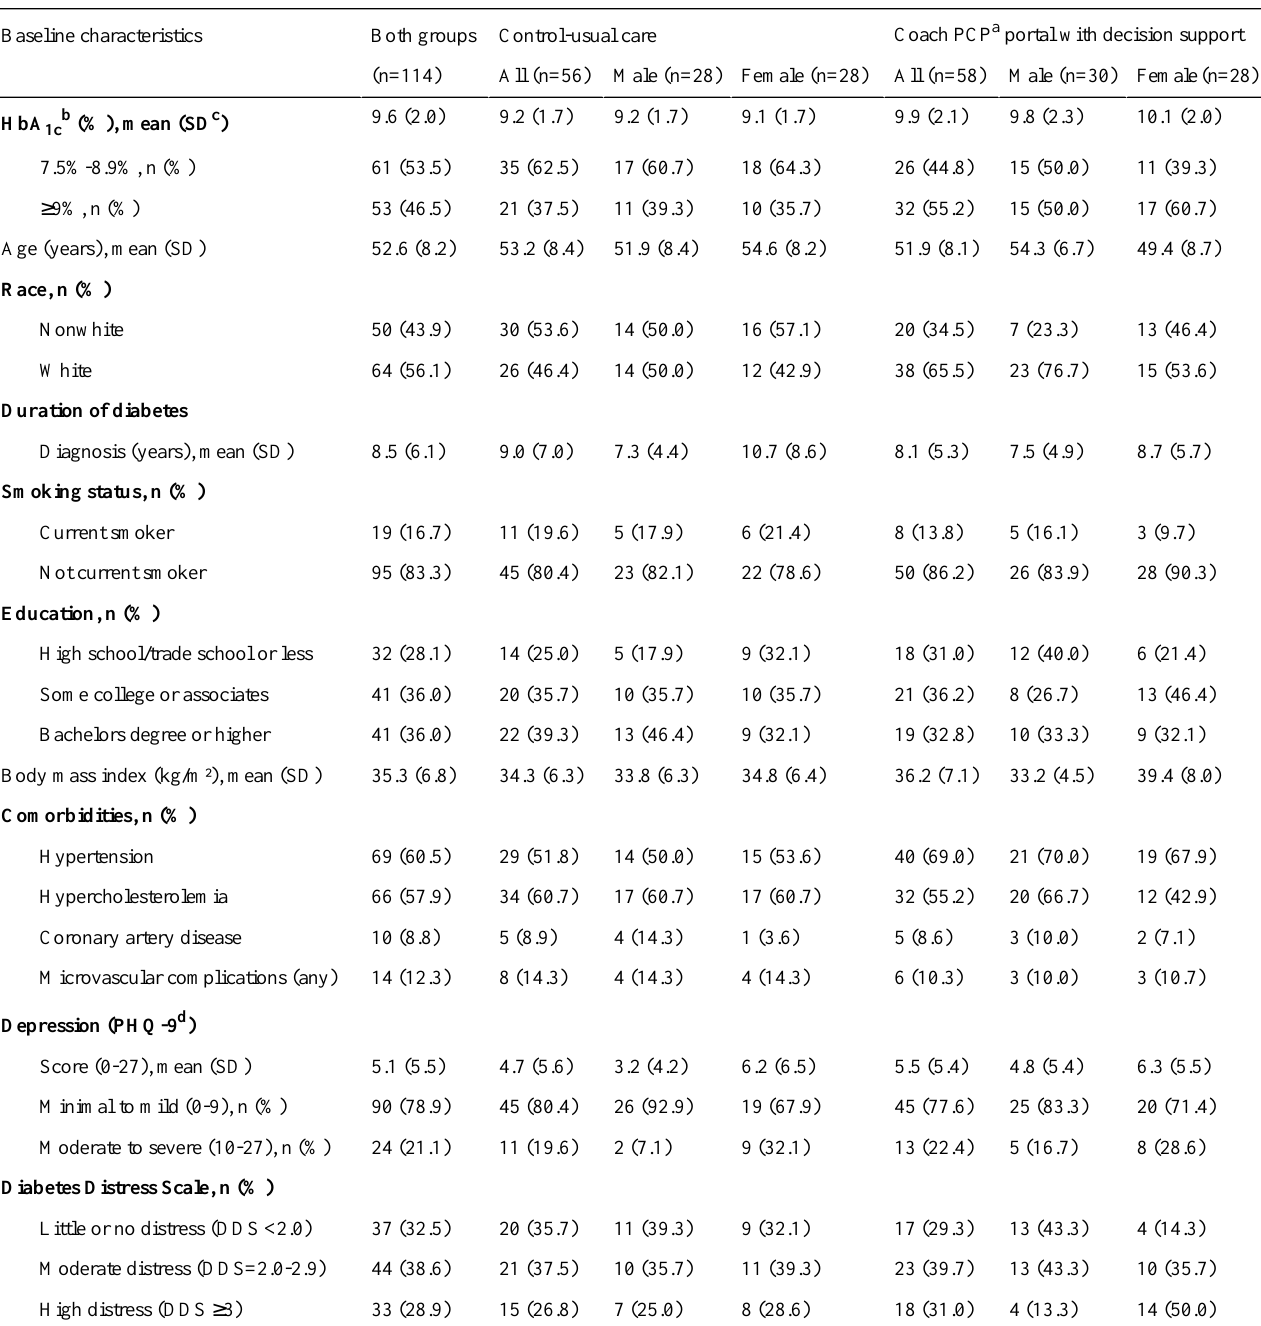
Table 1. Baseline characteristics of patients and primary and secondary outcomes.